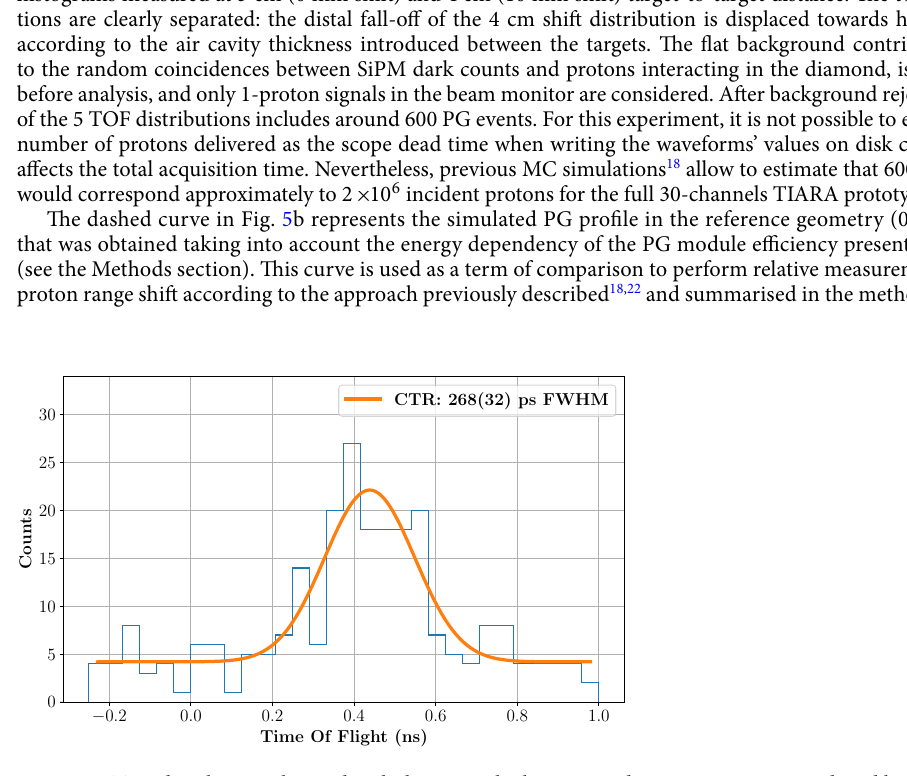
3 mm 2 SiPM and placed at 90 ◦ ×